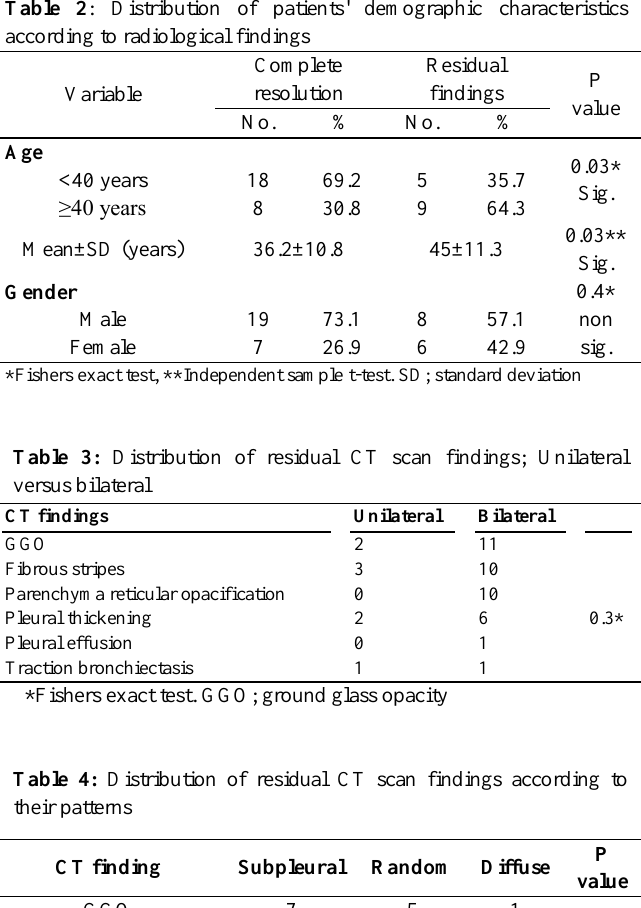
Table 2 : Distribution of patients' demographic characteristics